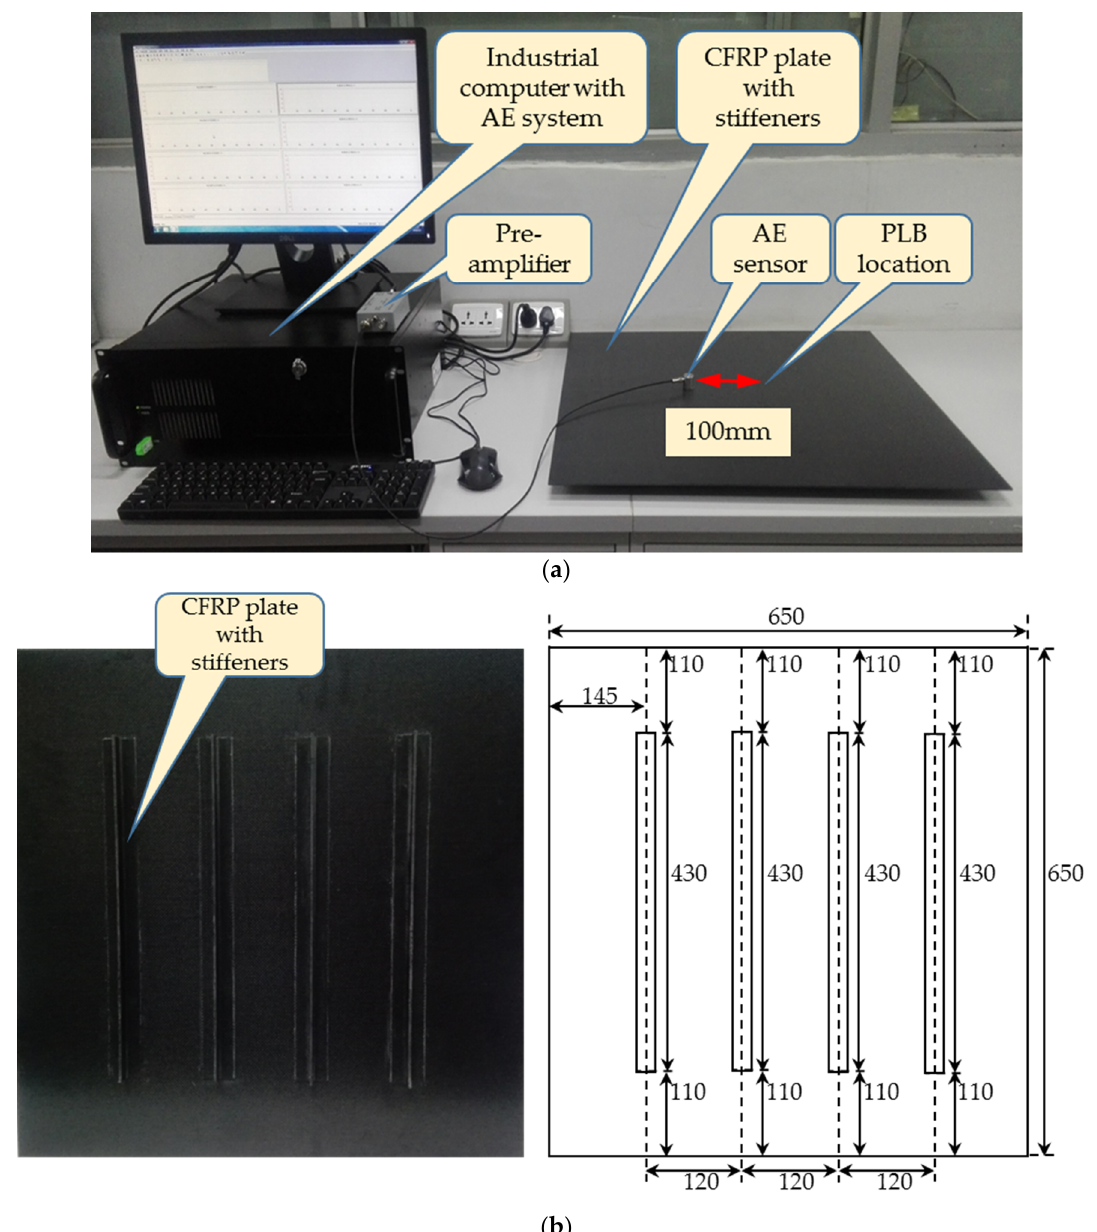
Figure 10. ( a ) The experimental system of PLB and ( b ) the configuration of CFRP plate with T stiffeners.